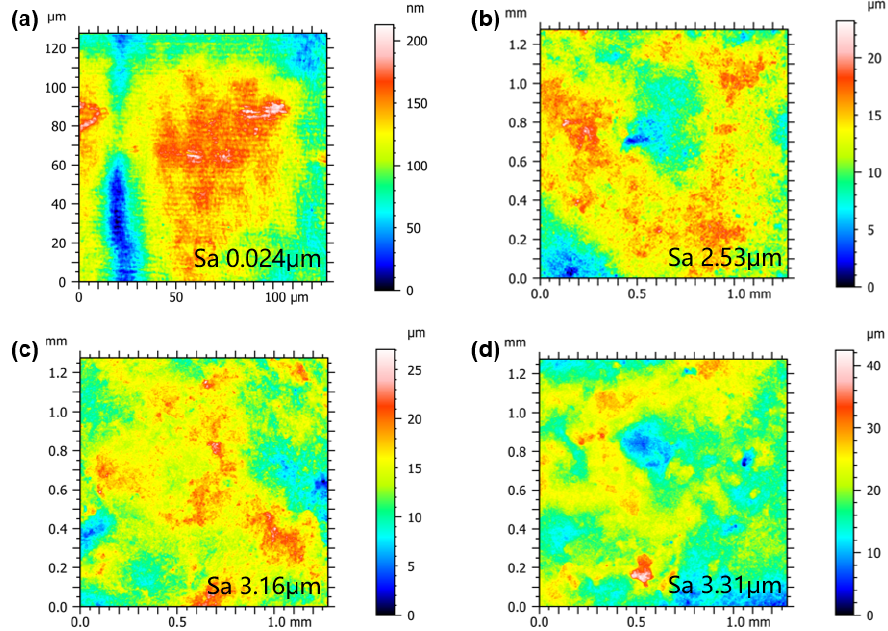
Figure 3. Images of the surface morphology for the M50 steel with different USP durations: ( a ) 0 min; ( b ) 1 min; ( c ) 5 min; ( d ) 10 min.